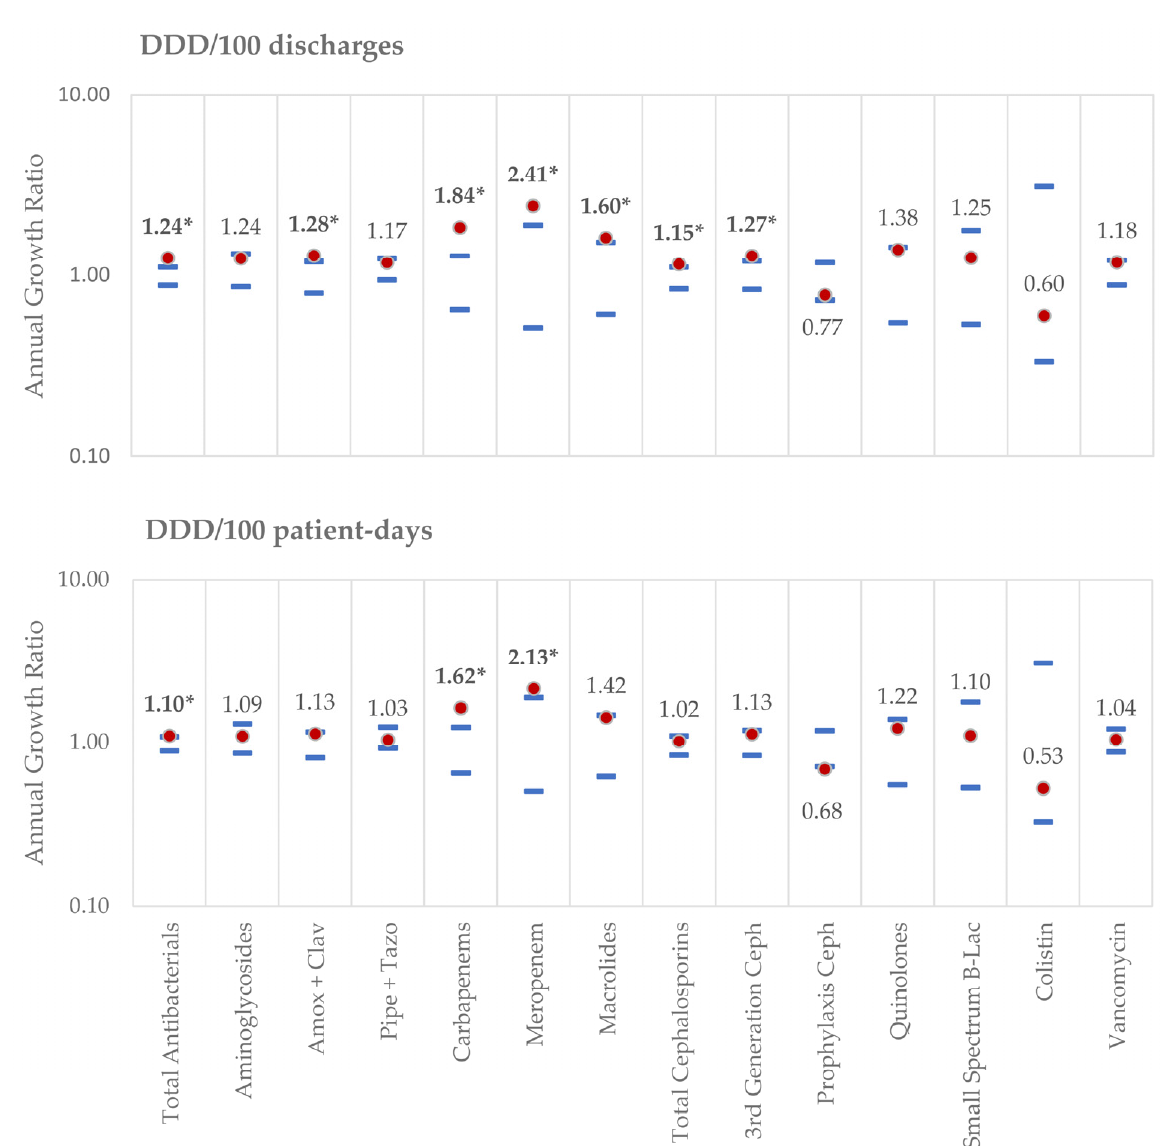
Figure 3. Annual growth ratio in 2020 and expected reference values for the period of 2011–2019. Calculated 2020 growth ratios (Indicatoryear (n+1)/Indicatoryear (n)) are represented by the red dot, whereas the upper and lower limits of the calculated reference values for 2011–2019 are represented by the blue lines. (*) Growth ratios outside the reference values were considered statistically significant. Growth ratios correspond to the logarithmic values of the APCs. As an example: total antibacterial use expressed as DDD/100 patient-days increased by 10% in 2020 (annual growth ratio = 1.10), whereas cefazolin/cefoxitin use decreased by 32% (annual growth ratio = 0.68).